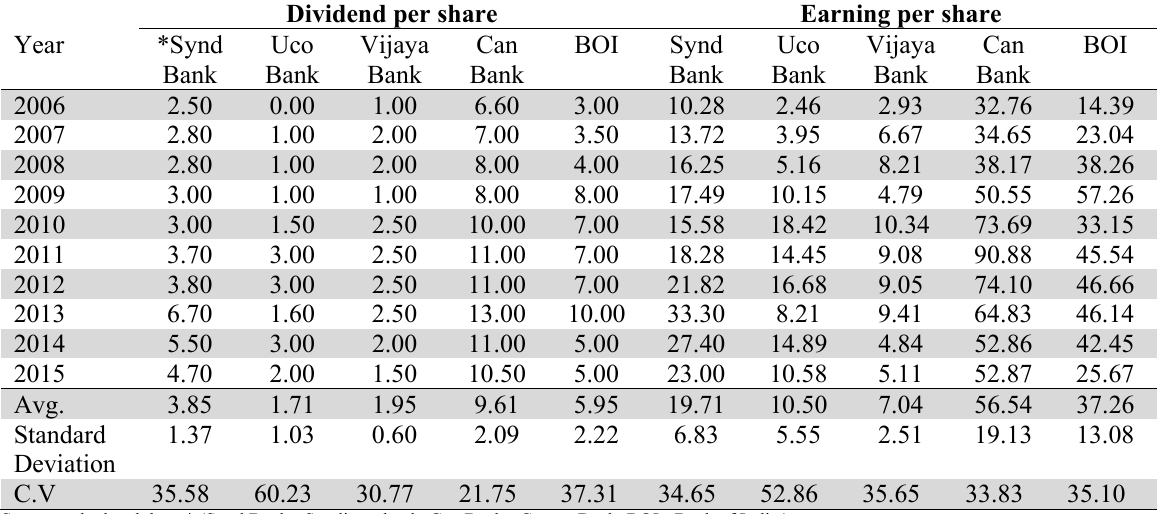
The information of dividend per share (DPS) and earning per share(EPS) of some selected Public Sector Banks in India from year March 2006 to March